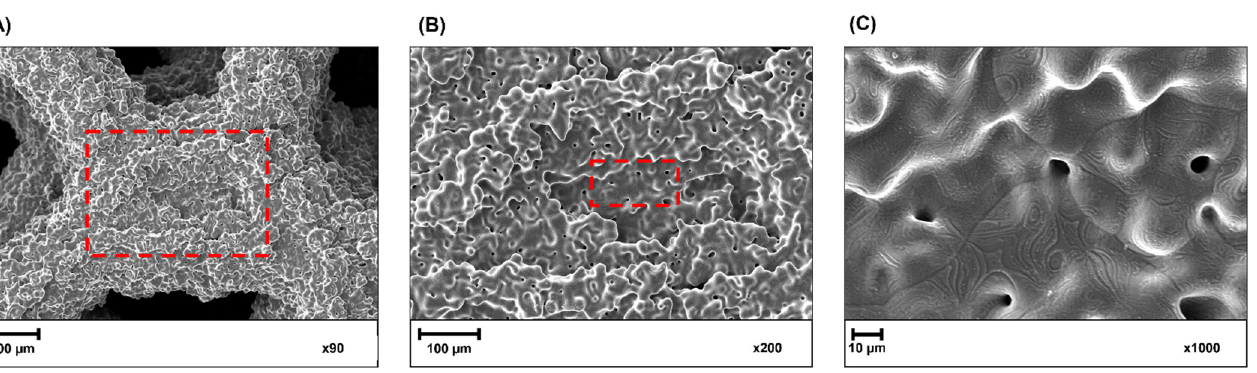
Figure 10. The SEM (PHENOM PRO) image of struns of the Voronoi structure before modification with DLC coating was obtained from a cross-section. In addition, the SEM images of the cross-section were used to analyze the internal porosity of the structure (Figure 11). The main challenge for additive manufacturing technologies is to produce elements with low internal porosity. The research shows, that internal porosity has a significant impact on the mechanical properties of the manufactured elements [20,22,23,25]. There are two types of internal pores: spherical (commonly due to trapped gas or material evaporation) and irregular (due to shrinkage, lack of fusion, or material feed shortage) [22]. Tillman et al. [37] also pay attention to the so-called residual porosity- open pores on the surface of binder jetting elements. They showed that the pore size of the surface has a significant influence on the growth mechanism of DLC coating.